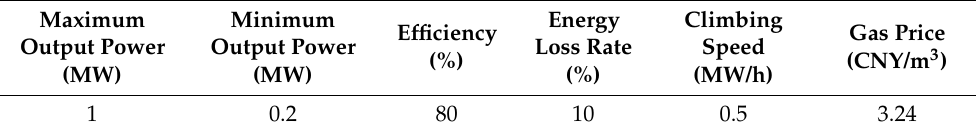
Table 1. Technical and economic parameters of the micro gas turbine.